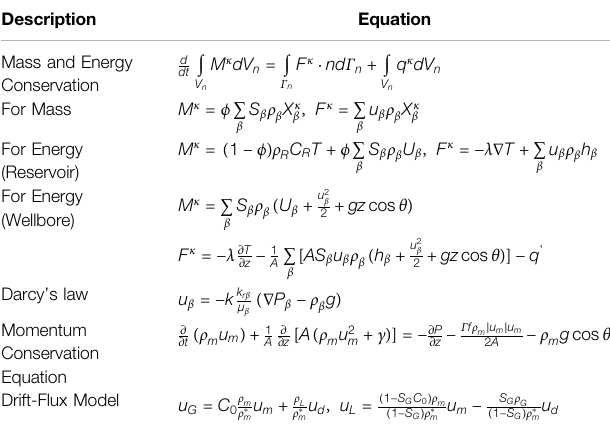
TABLE 1 | The governing equations solved in T2Well (Pan and Oldenburg, 2014).